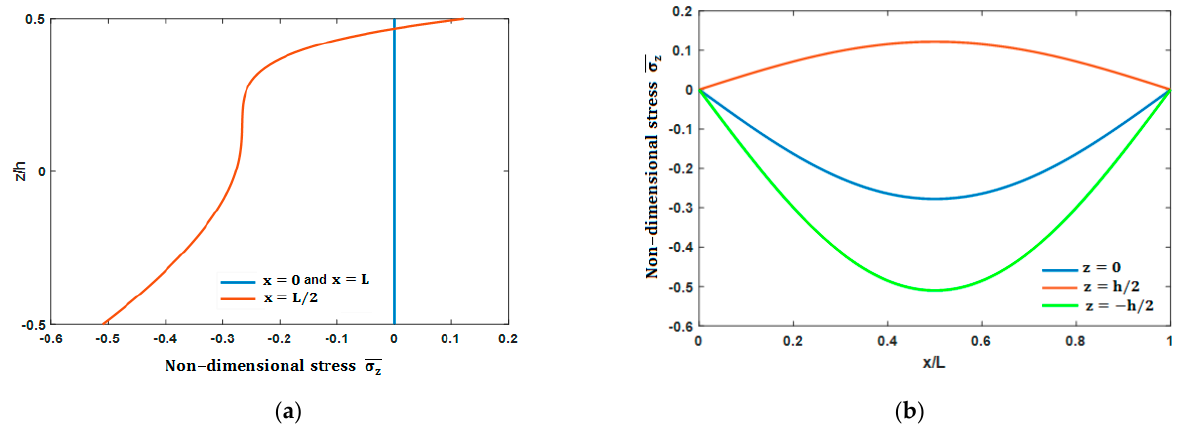
Figure 11. 𝜎 (cid:3053) distributions: ( a ) over the FG beam thickness; ( b ) versus the FG beam non-dimensional length.